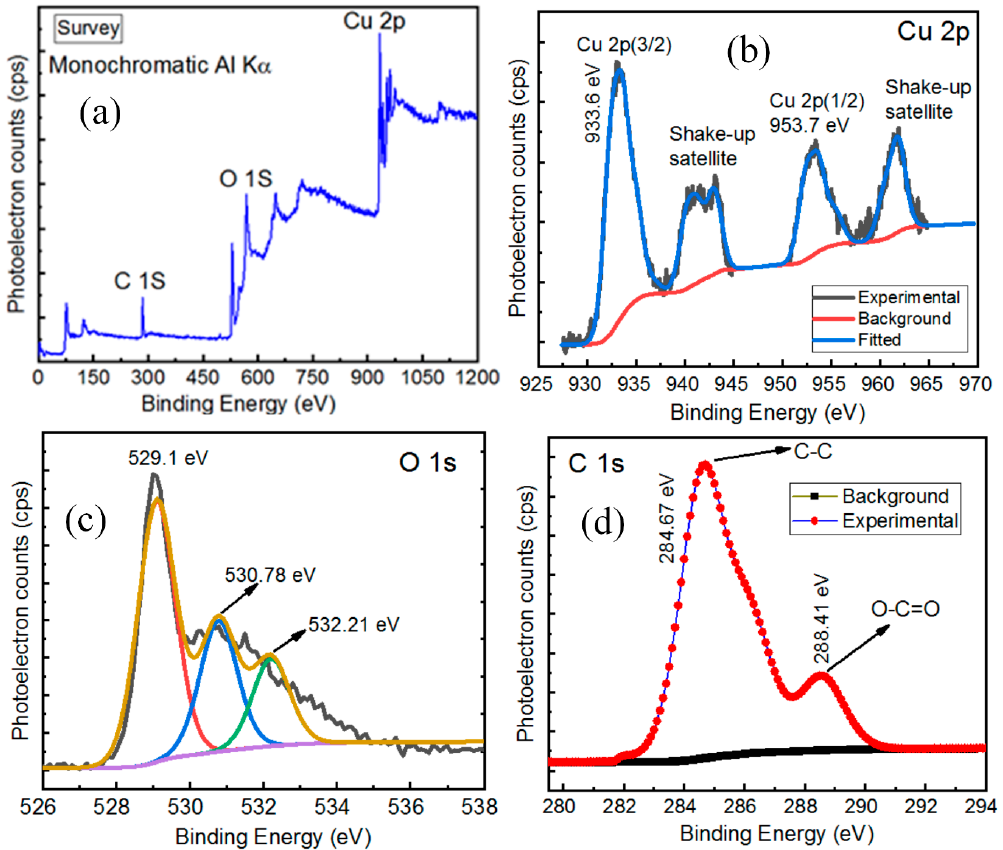
Figure 3. ( a ) Survey or wide energy range X-ray photoelectron spectroscopy (XPS) spectra of CuO nanopetals. ( b – d ) High resolution (Core level) or narrow energy range spectra of Cu 2p, O 1s, and C 1s from as synthesized CuO nanopetals, respectively.